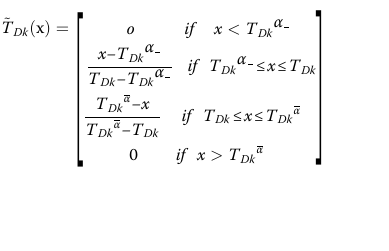
compressed pattern simulated and its Time vs Distance diagram can be found in Fig. 1.